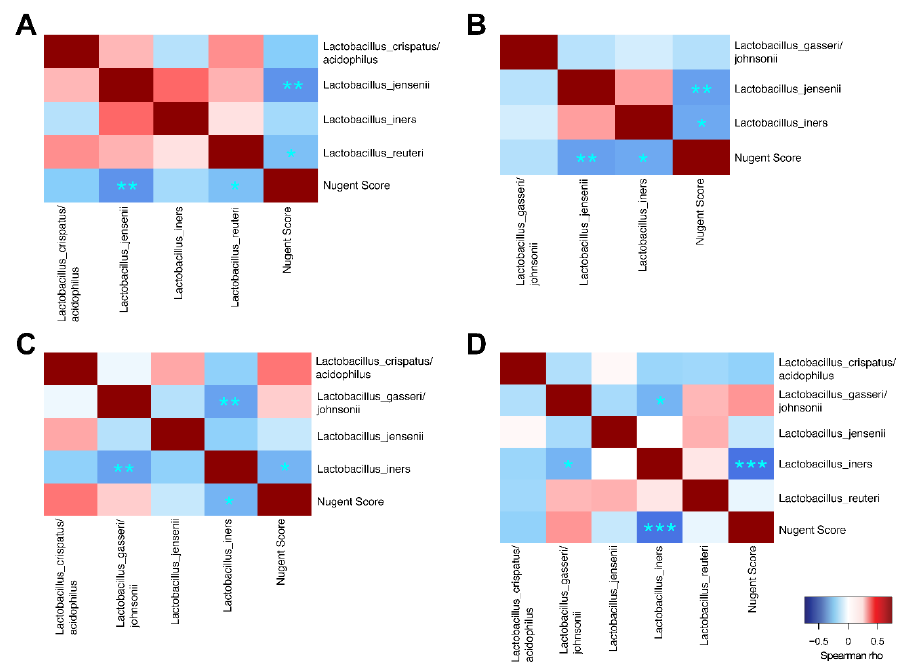
Figure 8. Spearman correlation analyses between vaginal Lactobacillus species and to Nugent score for Group 1 ( A ), Group 2 Day 1 ( B ), Group 2 Day 8 ( C ) and Group 2 Day 15 ( D ). *** p < 0.001, ** p < 0.01, * p < 0.05.